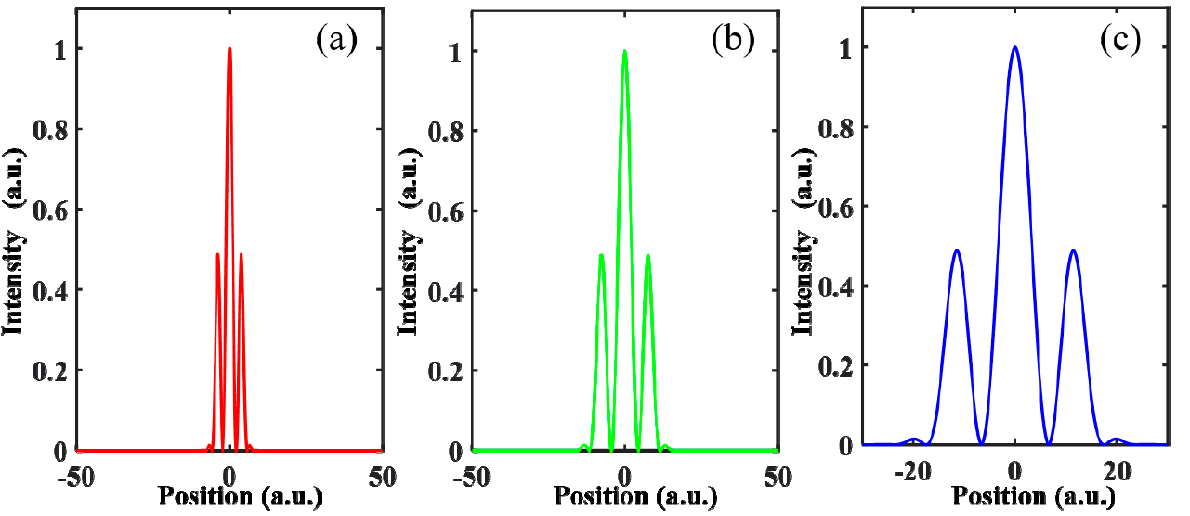
Figure 3. When ϕ 0 = 2 π /3, the waveform of Cos − Gaussian pulses with different initial widths x 0 : ( a ) x 0 = 1, ( b ) x 0 = 2, and ( c ) x 0 = 3.